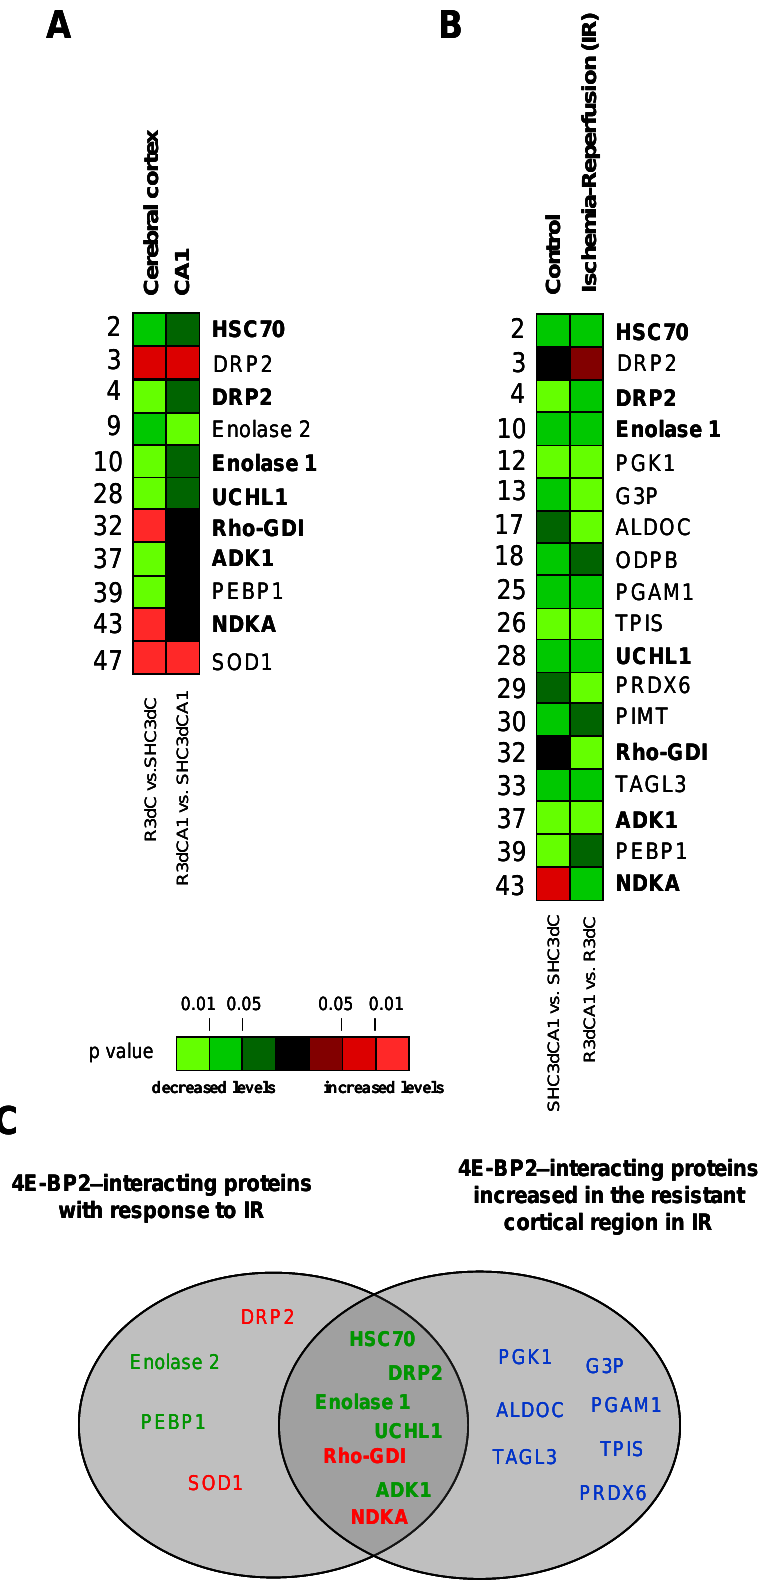
Figure 5. 4E-BP2-interacting proteins with significant differences between the cortical and CA1 regions, in control and ischemic samples. Identified 4E-BP2-interacting proteins were quantified for biological variation analysis and data were compared between the ischemic group and their con-